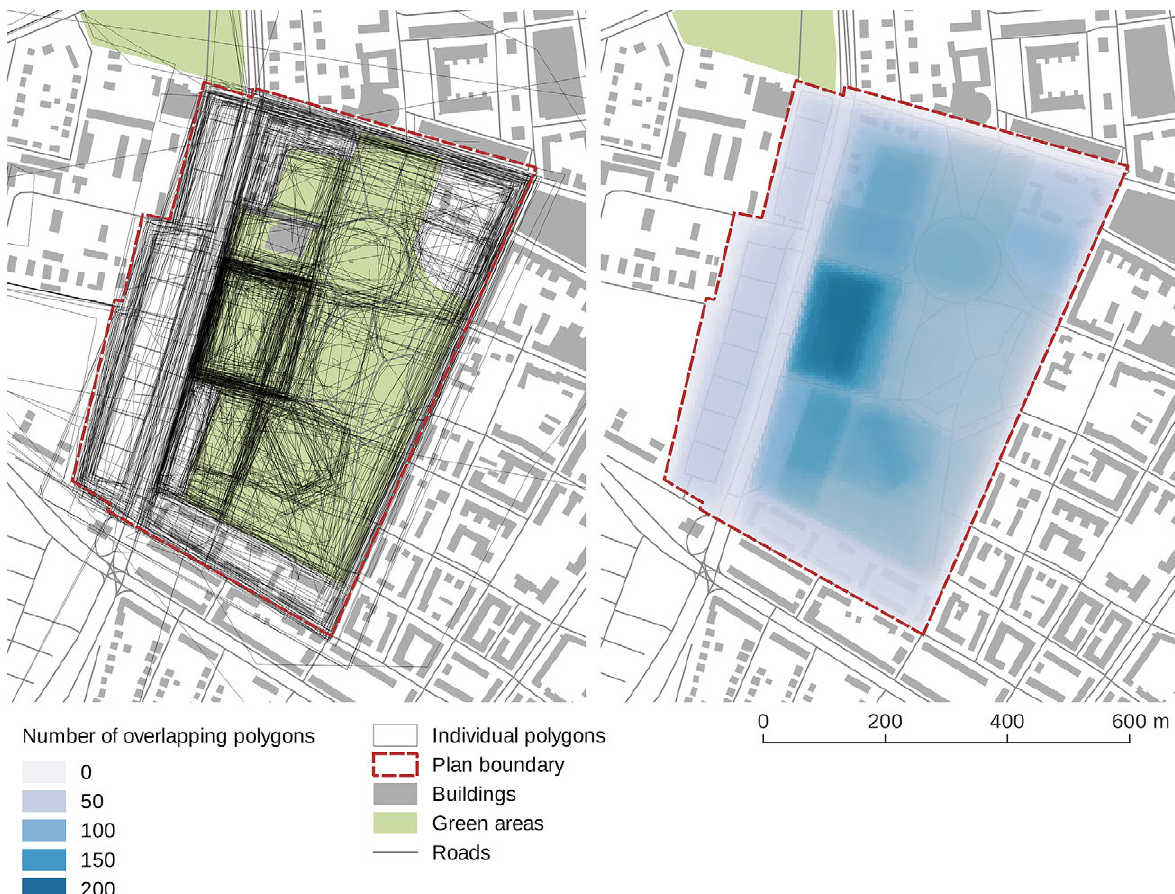
Fig. 3. Aggregated analysis of polygon markings. The polygons represent areas that, according to the geo- questionnaire respondents, should change its function to sport and recreation facilities. The map frame on the left presents raw polygon features as sketched by participants. The map frame on the right presents an aggregated map, in which the raster cell values represent the number of polygons overlapping each cell. Sources: topographic data © OpenStreetMap contributors; thematic data collected in the Kasprowicz Park case